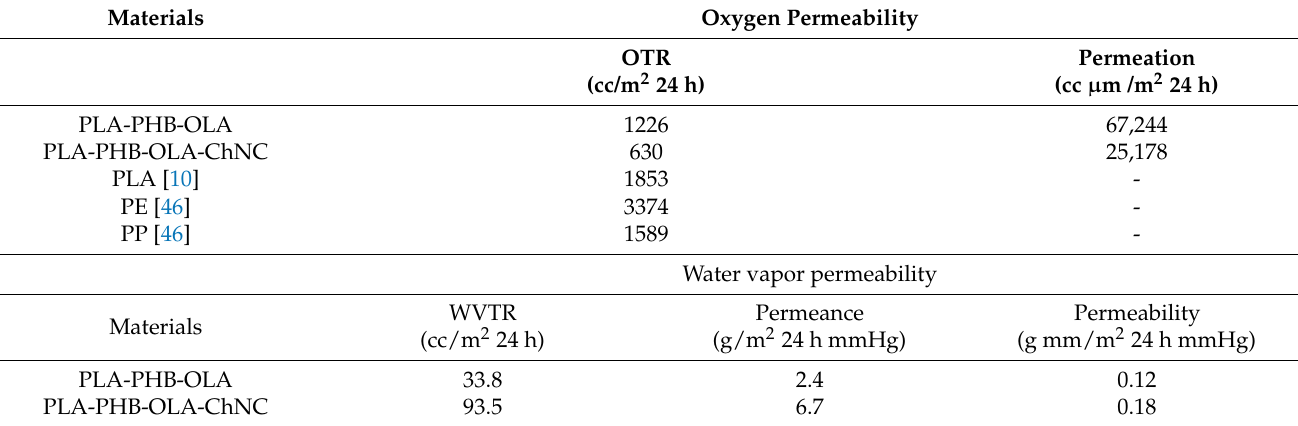
Table 6. Oxygen and water vapor barrier properties of produced